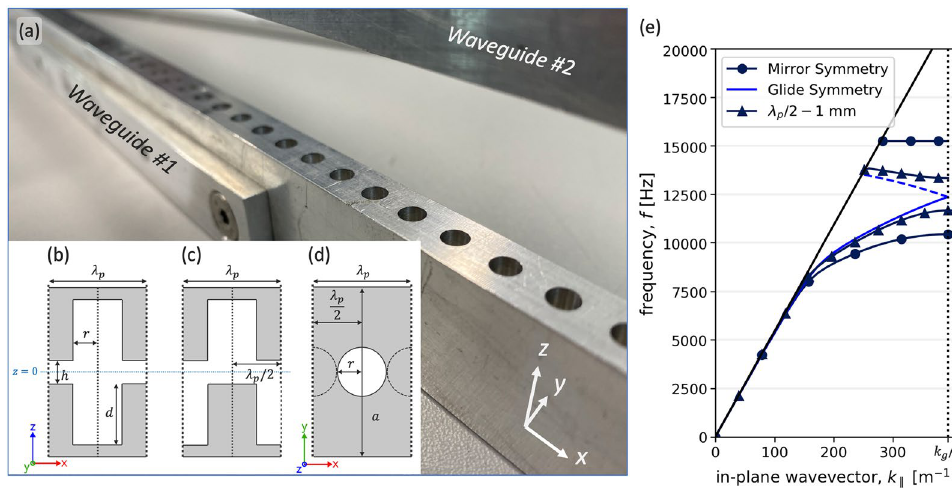
Figure 1. ( a,b,c,d ) Photograph and schematic diagrams of the sample shown in both mirror and glide symmetry arrangements. In ( b , c , d ), areas of grey represent aluminium, and white represents air. The sample has a periodicity (cid:31) p = 8 mm along the x axis, and is patterned with cylindrical resonators with depth d = 5 mm and radius r = 2 mm. Both surfaces have width a = 10 mm in the y axis. These two surfaces, whether in mirror or glide symmetry, are separated by height h , which may be varied. ( a ) Photograph of the aluminium sample. ( b ) Schematic showing mirror symmetry, where the patterned surfaces are perfectly mirrored normal to the z axis. ( c ) Shows glide symmetry, where the surfaces are mirrored normal to the z axis and translated along the x axis by half a unit cell period ( (cid:31) p /2). ( d ) A top view of the sample in glide symmetry, where the opposing surface resonators are indicated as dashed lines. ( e ) FEM calculated dispersion relations of eigenmode solutions showing the acoustic surface waves supported on the sample in mirror and glide symmetry arrangements, as well as (cid:31) p / 2 − 1 mm for surface separation h = 1.5 mm. Dashed lines indicate modes that have been scattered back into the 1st BZB. The solid black line represents the sound-line ( k 0 ) with vertical dotted line indicating the first BZB at k (cid:31) = k g / 2